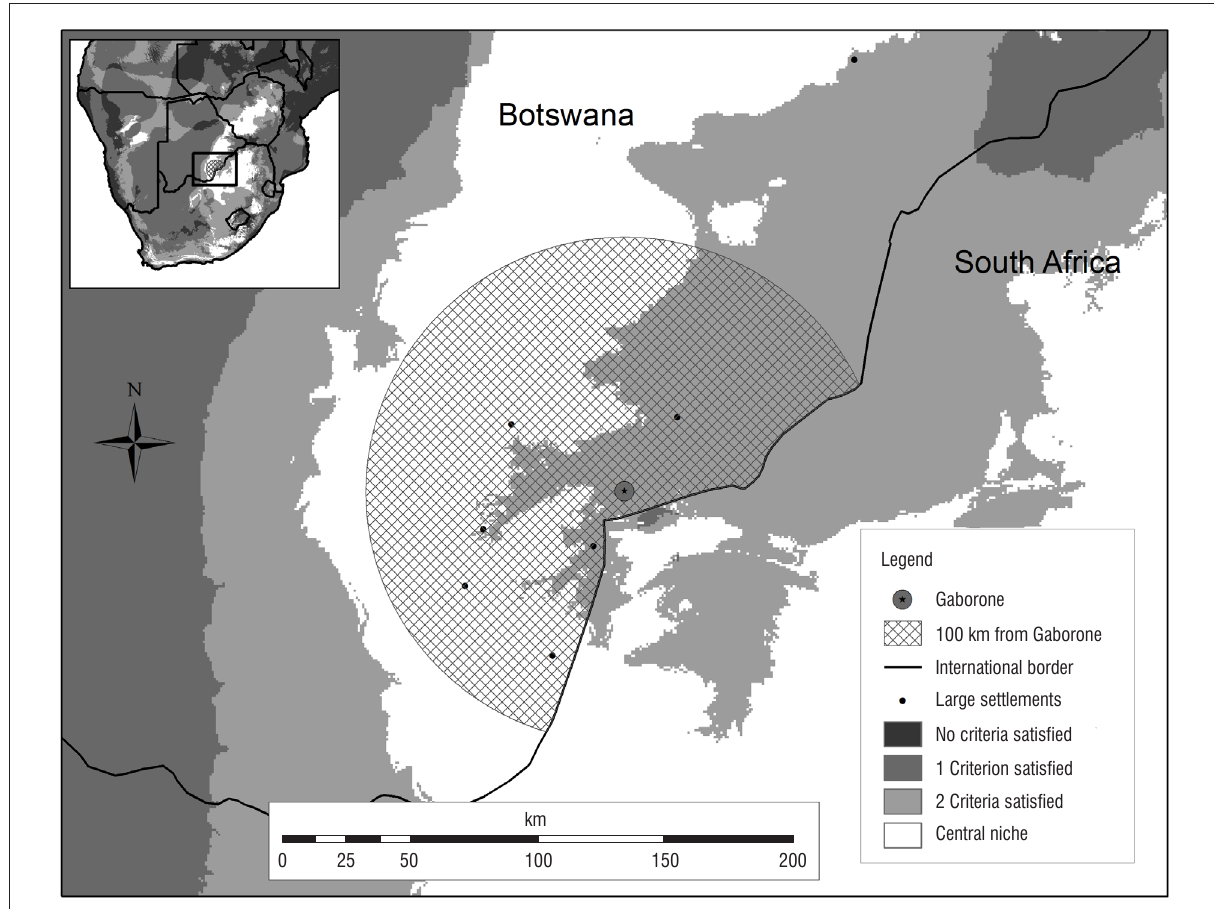
Figure 5: The 100-km zone surrounding Gaborone (Botswana), overlaid onto the predicted environmental central niche of the chacma